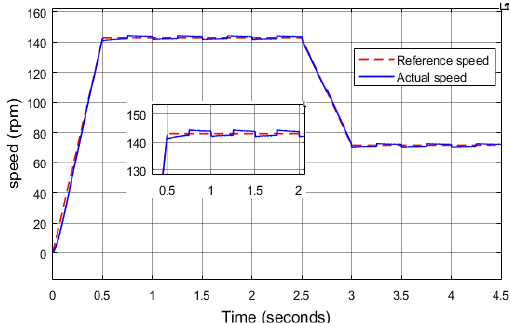
Fig. 11. Reference speed at 50%-25% rating speed: HPWM technique without current sensors at pulse load torque.